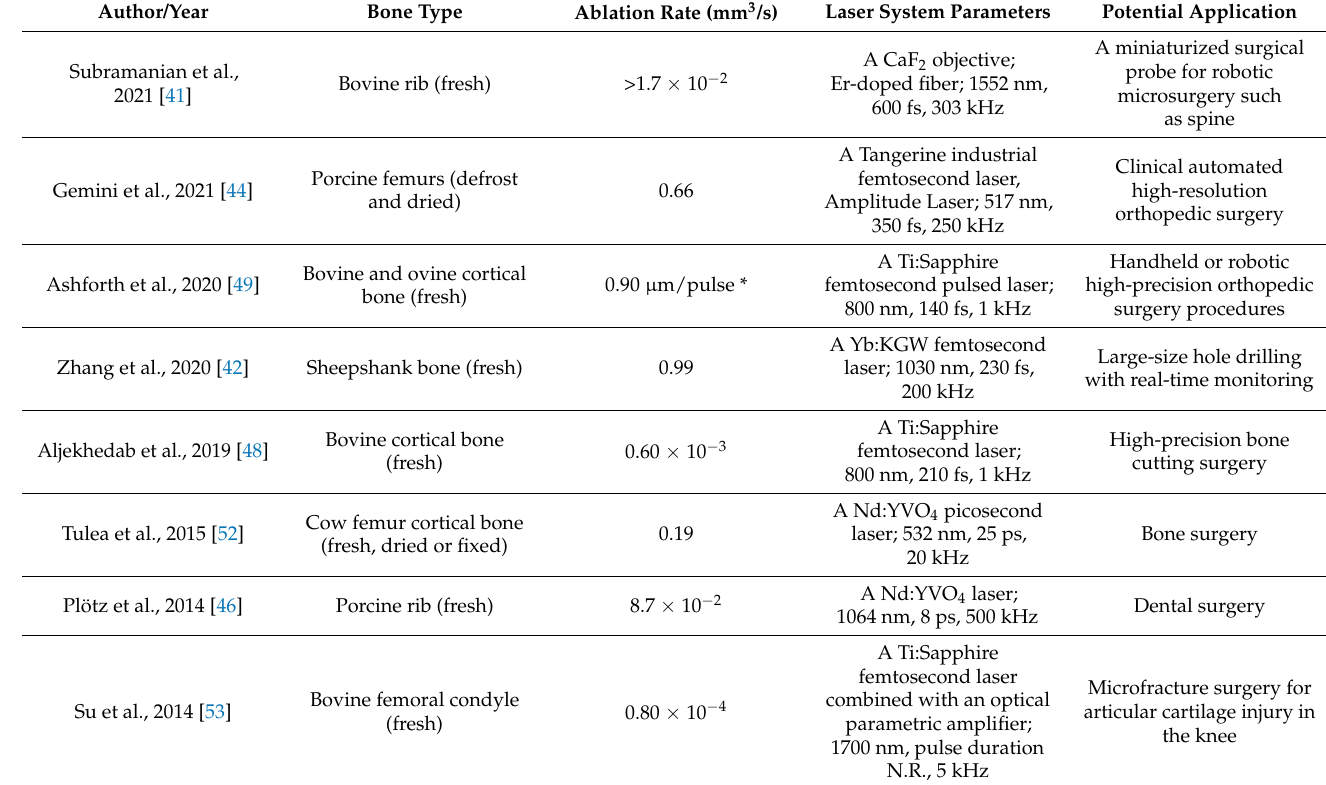
Table 2. Summary of recent studies on the use of ultrafast lasers for orthopedic